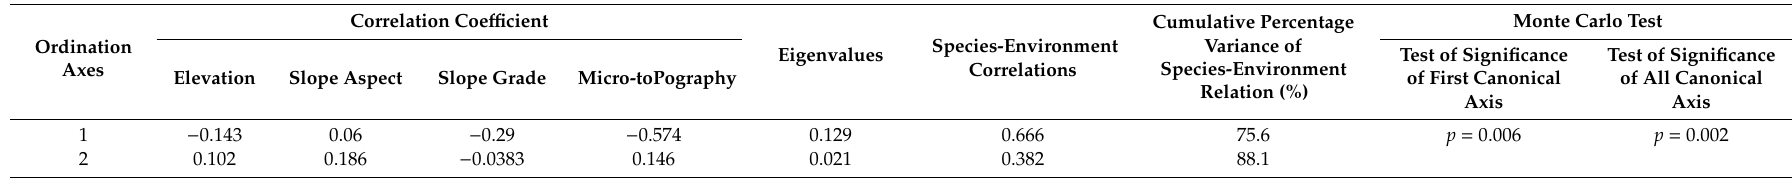
Table 4. Results of ordination based on redundancy analysis (RDA) of eight dominant species and di ff erent environmental factors, which is set in the tundra of the Changbai Mountains, Jilin,